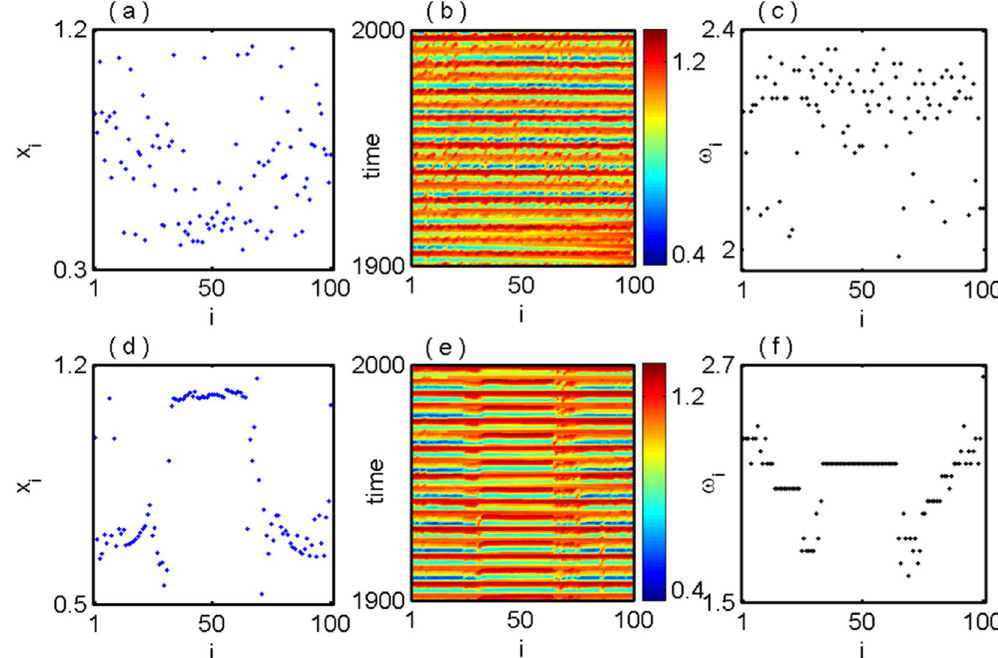
Figure 1. Nonlocally coupled Mackey-Glass systems: coexistence of incoherent and chimera states at fixed coupling strength  = . 0 35 and coupling radius R = 0.3 for different initial conditions ( a , b , c ) c = 0.001 and ( d , e , f ) c = 0.03. Left columns show snapshot of amplitude x i (i = 1,2, … , N) in blue points, middle columns for space-time plot and right columns for time average phase velocities ω i (black dotted points).